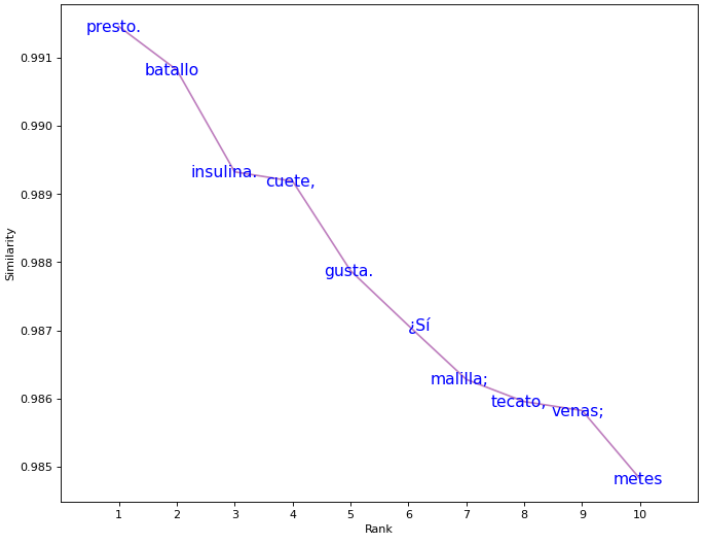
Figure 1. 10 most similar words for insulin